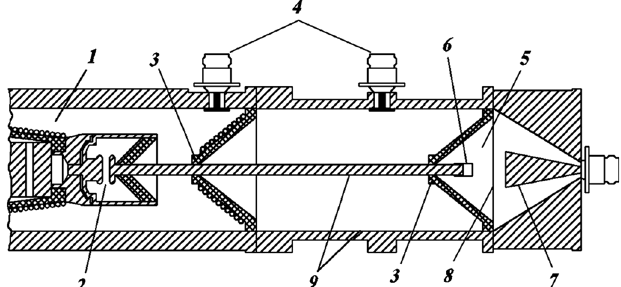
FIG. 1. Schematic picture of the SLEP-150M pulser with a gas- filled diode and a collector: (1) output section of pulser, (2) peaking spark gap, (3) insulators, (4) capacitive dividers, (5) gas filled diode, (6) cathode, (7) receiving part of the collector, (8) foil reinforced with a grid, (9) transmission